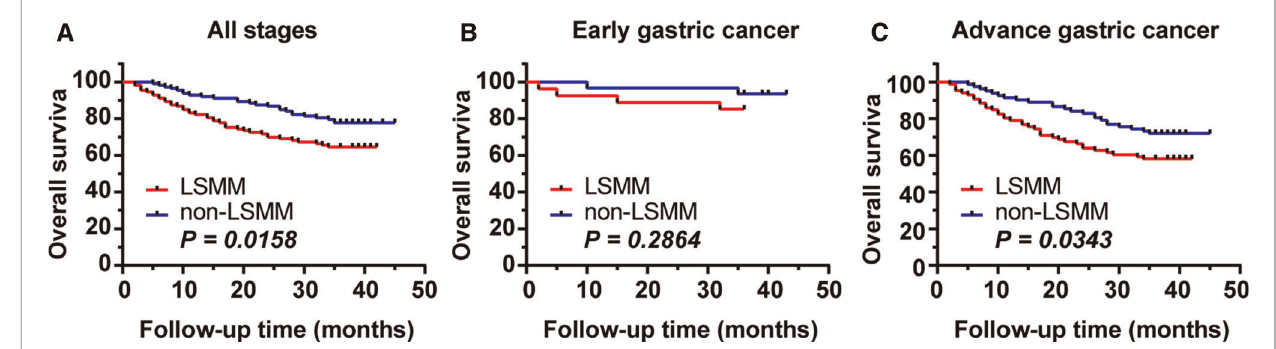
FIGURE 2 | Impact of LSMM on OS. ( A ) in all patients of GC. The 3-year OS rate was 71.24% for all patients, 64.6% and 77.9% for LSMM and non-LSMM groups respectively ( p =0.0158). ( B ) in the early GC. The 3-year OS rate were 85.16% and 93.55% for the LSMM and non-LSMM groups respectively ( p =0.2864). ( C ) in the advance GC. The 3-year OS rate were 58.14% and 71.95% for the LSMM and non-LSMM groups respectively ( p